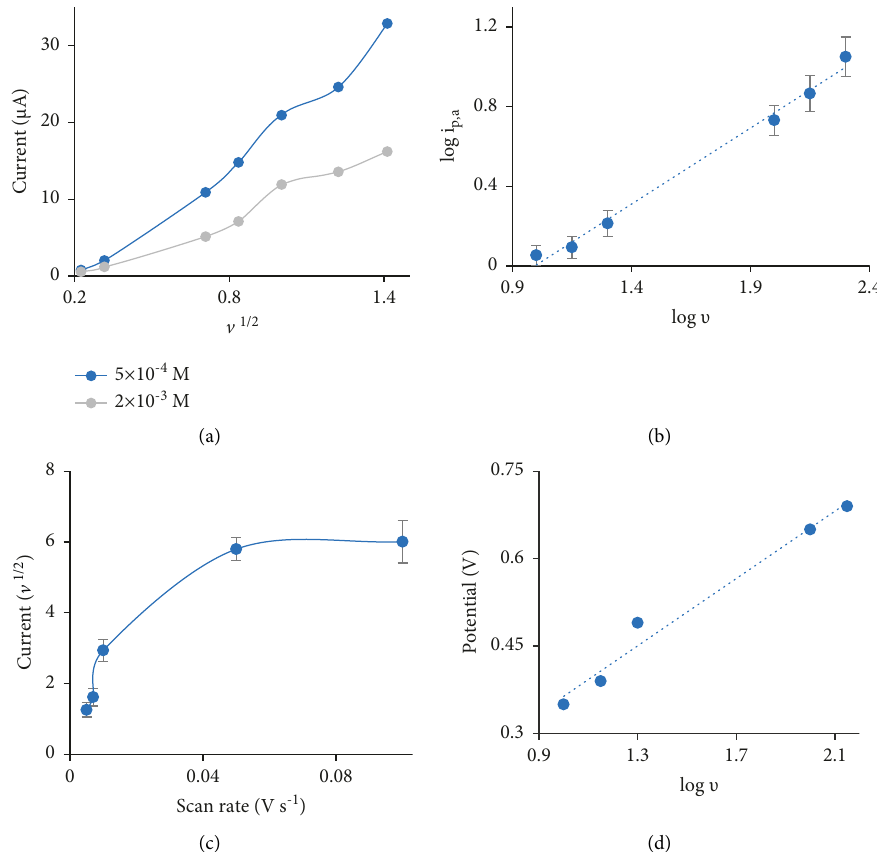
4 (M) vs. square root of scan rate ( υ 1/2 ) at different concentrations Figure 4: Plots of the anodic peak current ( i p,a ) at 0.4V of DCS 1.5 × 10 − (a); log i p,a of DCS vs. log ] (b); Current function ( i p,a / ] 1/2 ) vs. scan rate (c) and anodic peak potential ( E p, a ) vs. log ʋ (d) in B-R buffer (pH at GCE vs. Ag/AgCl electrode using cyclic